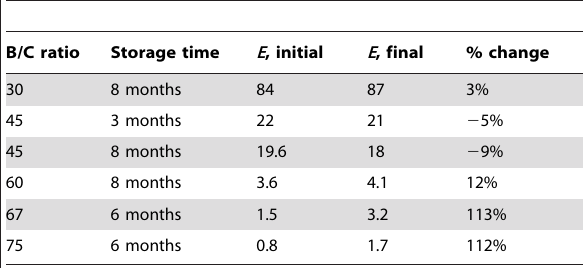
Table 1. Changes in the elastic moduli of different silicone gels over time.